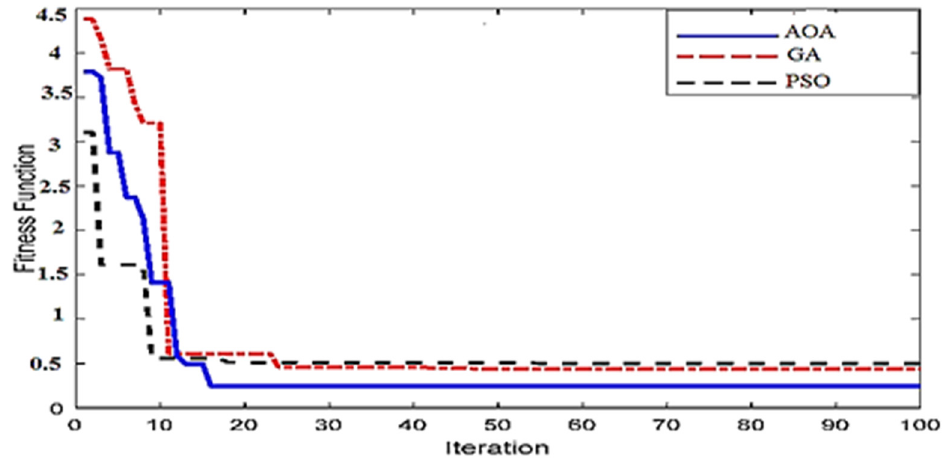
Figure 9. Fitness function convergence curves.